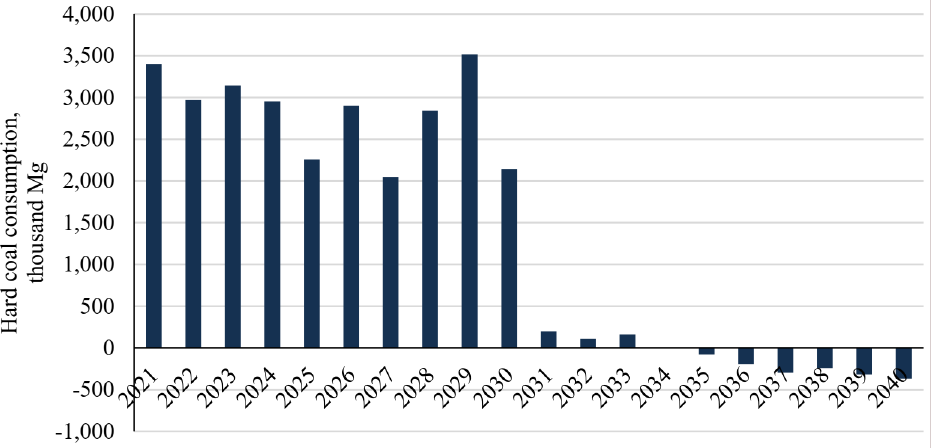
Figure 16. Differences in hard coal consumption between the CM and EOM scenarios in